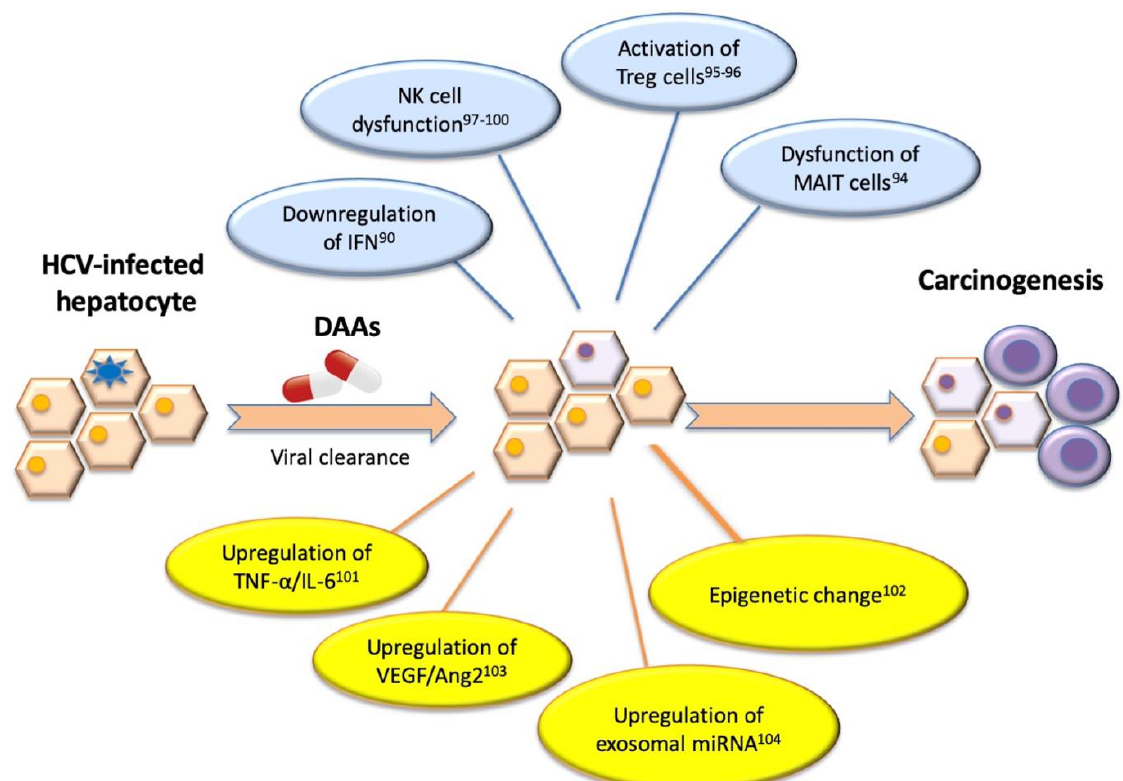
Figure 2. Molecular mechanism associated with HCC recurrence in chronic hepatitis C patients achieved sustained virologic response after DAA treatment. Different pathogenetic hypotheses have been postulated to investigate the development of HCC mainly based on some possible potential mechanisms including immune cell dysfunction, change in immune cytokine network, activation of angiogenesis, and epigenetic change after DAA therapy. Abbreviations: Ang2, angiopoietin-2; DAA, direct acting antiviral agents; IFN, interferon; MAIT, mucosal associated invariant T; miRNA, microRNA; NK, nature killer; TNF, tumor necrosis factor; Treg, regulatory T cell; VEGF, vascular endothelial growth factor.